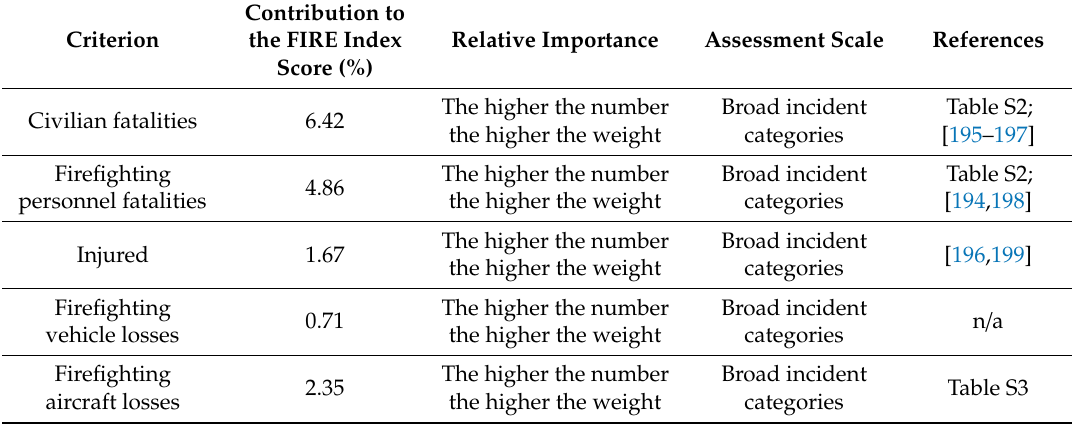
Table 5. Relative importance, assessment scale and relevant literature for each criterion for the casualties and fatalities fire e ff ects